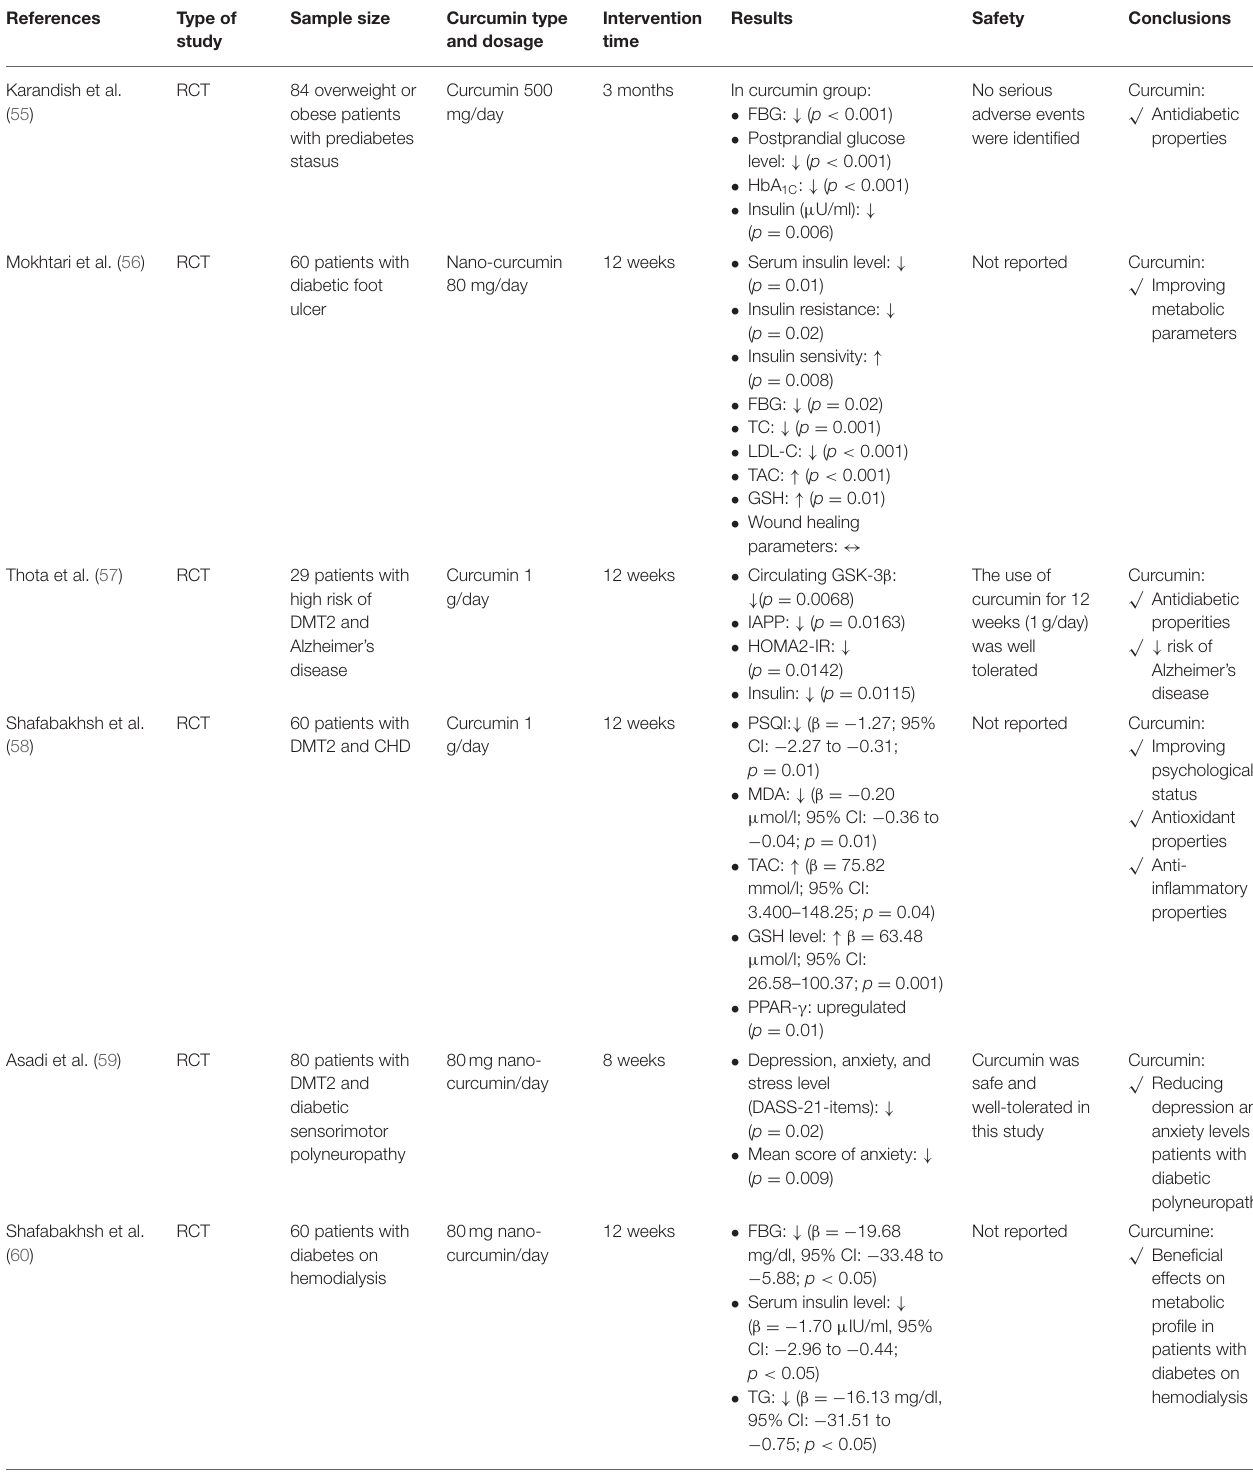
TABLE 2 | Summary of studies on the effects of curcumin on the prevention and control of type 2